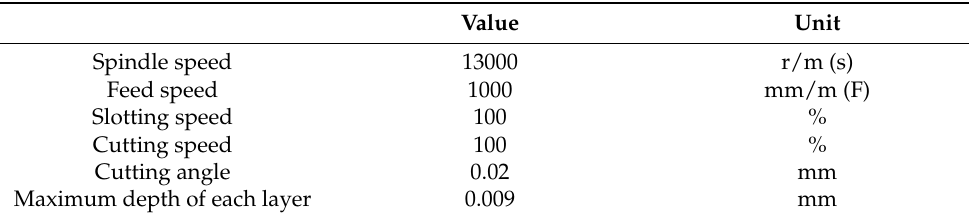
Table 2. Main parameters of micromachining equipment.